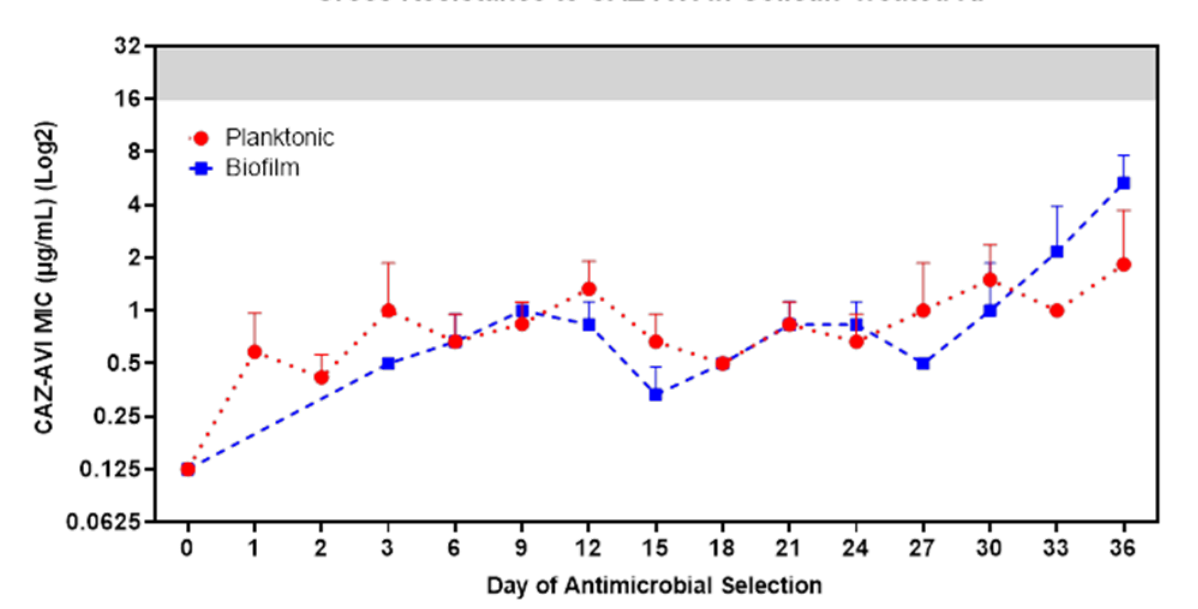
Figure 6. COL-R isolates do not generate cross-resistance to CAZ/AVI. Following 36 days of exper- imental evolutions of KP ATCC 43816 under colistin selection, cross-resistance to CAZ/AVI was assessed for COL-R planktonic (red) and biofilm (blue) isolates from all populations in all timepoints. The clinical breakpoint for CAZ/AVI is 16 µg/mL, and the resistance MIC area is shown in a gray background. The data points reflect the mean MIC to CAZ/AVI of three replicate populations by lifestyles and colistin treatment conditions. Data are representative of three independent experiments.